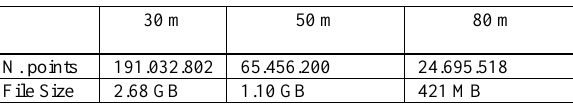
The figures 8, 9 and 10 show the dense point cloud for each flight.